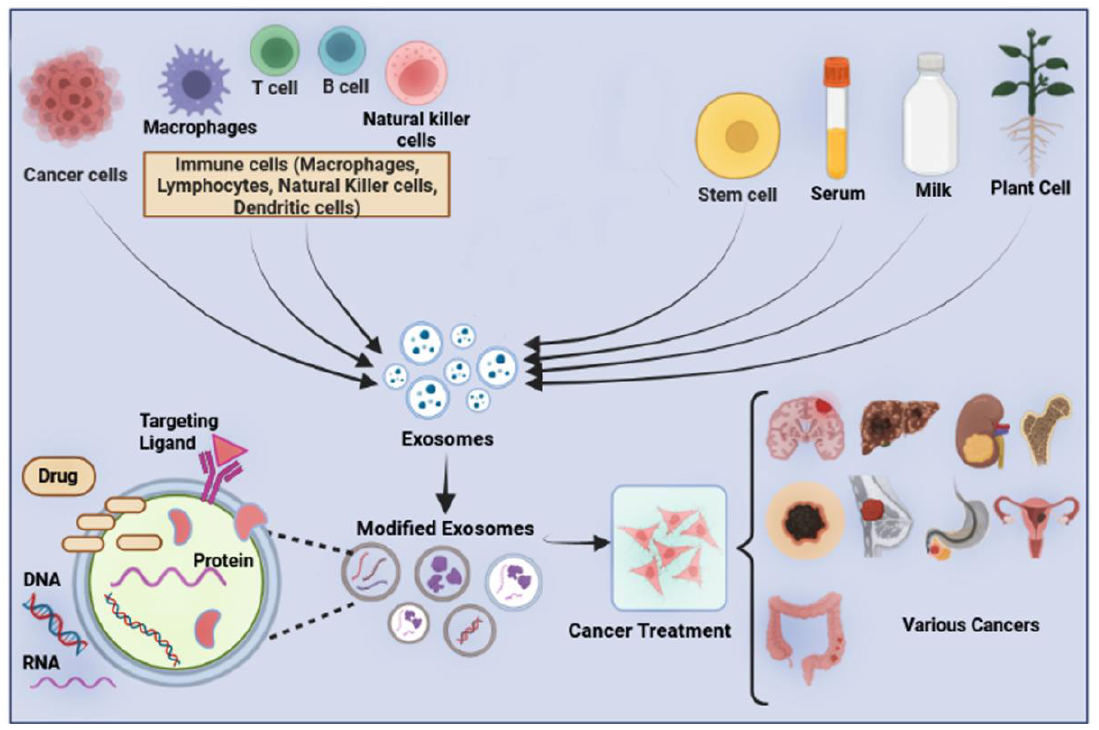
Figure 2. Various exosomes from different cells or body fluids are used for drug delivery system.